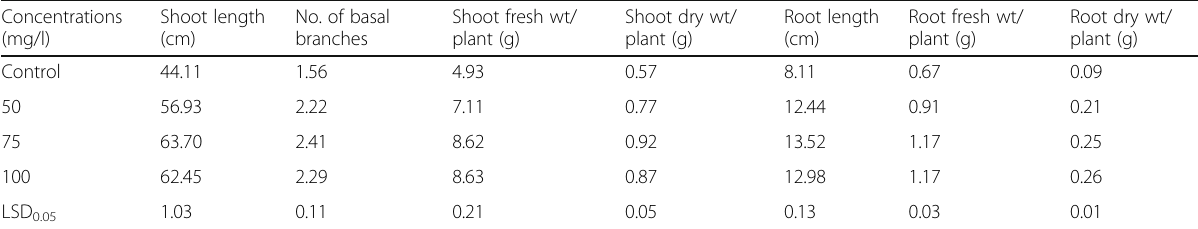
Table 8 Effect of concentrations on growth criteria of flax plants grown under sandy soil conditions (data are means of two seasons) Concentrations